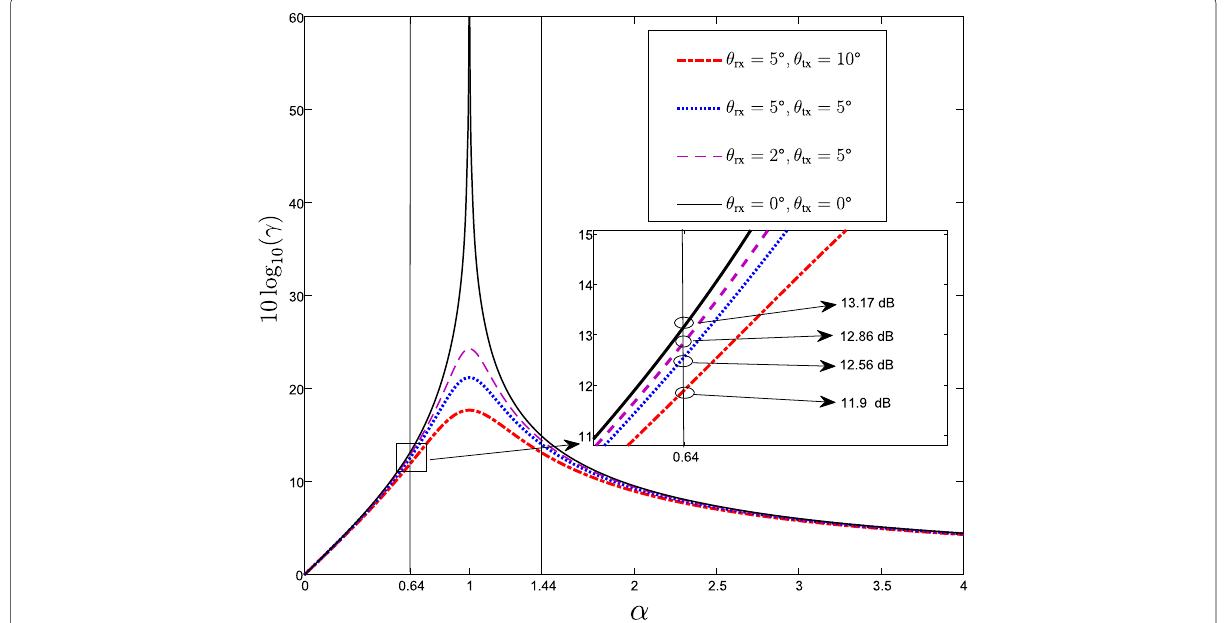
Fig. 5 The range of 10log 10 (γ) vs. α under different θ rx and θ